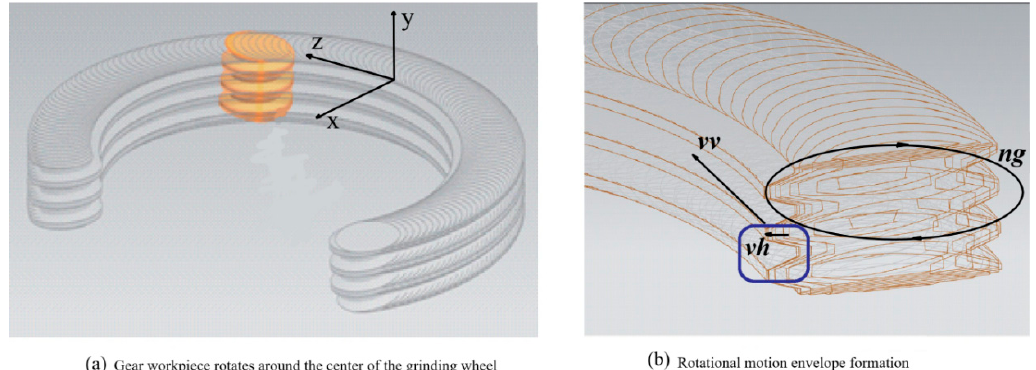
Figure 4. Schematic diagram of the worm wheel grinding principle.